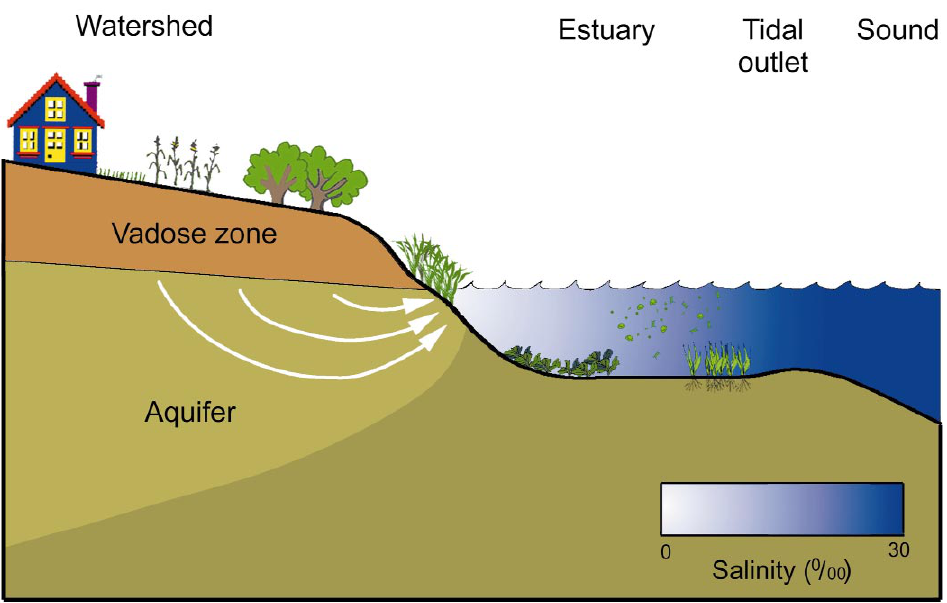
F IG . 1. – Sketch of the coupled land/estuarine tesserae found in the Waquoit Bay estuarine system. Land covers include residential, agricul- tural, and natural vegetation. Salt marshes are interposed between land and the receiving estuary. In this glacial terrain, precipitation perco- lates through soils and the unsaturated vadose zone (tan color), to reach the water table and the aquifer (light green), where it then moves as fresh groundwater (white arrows) toward the estuary, floating over the saline water (darker green) that fills pore spaces under the estuary, and flows into the estuary at the seepage face. Estuarine salinity is identified by intensity of blue color. In the estuary, there are phytoplankton, macroalgae, and seagrasses that contribute to primary production. The estuary exchanges water with the deeper Vineyard Sound, which contributes saltier water to mix with fresh groundwater derived from precipitation and groundwater